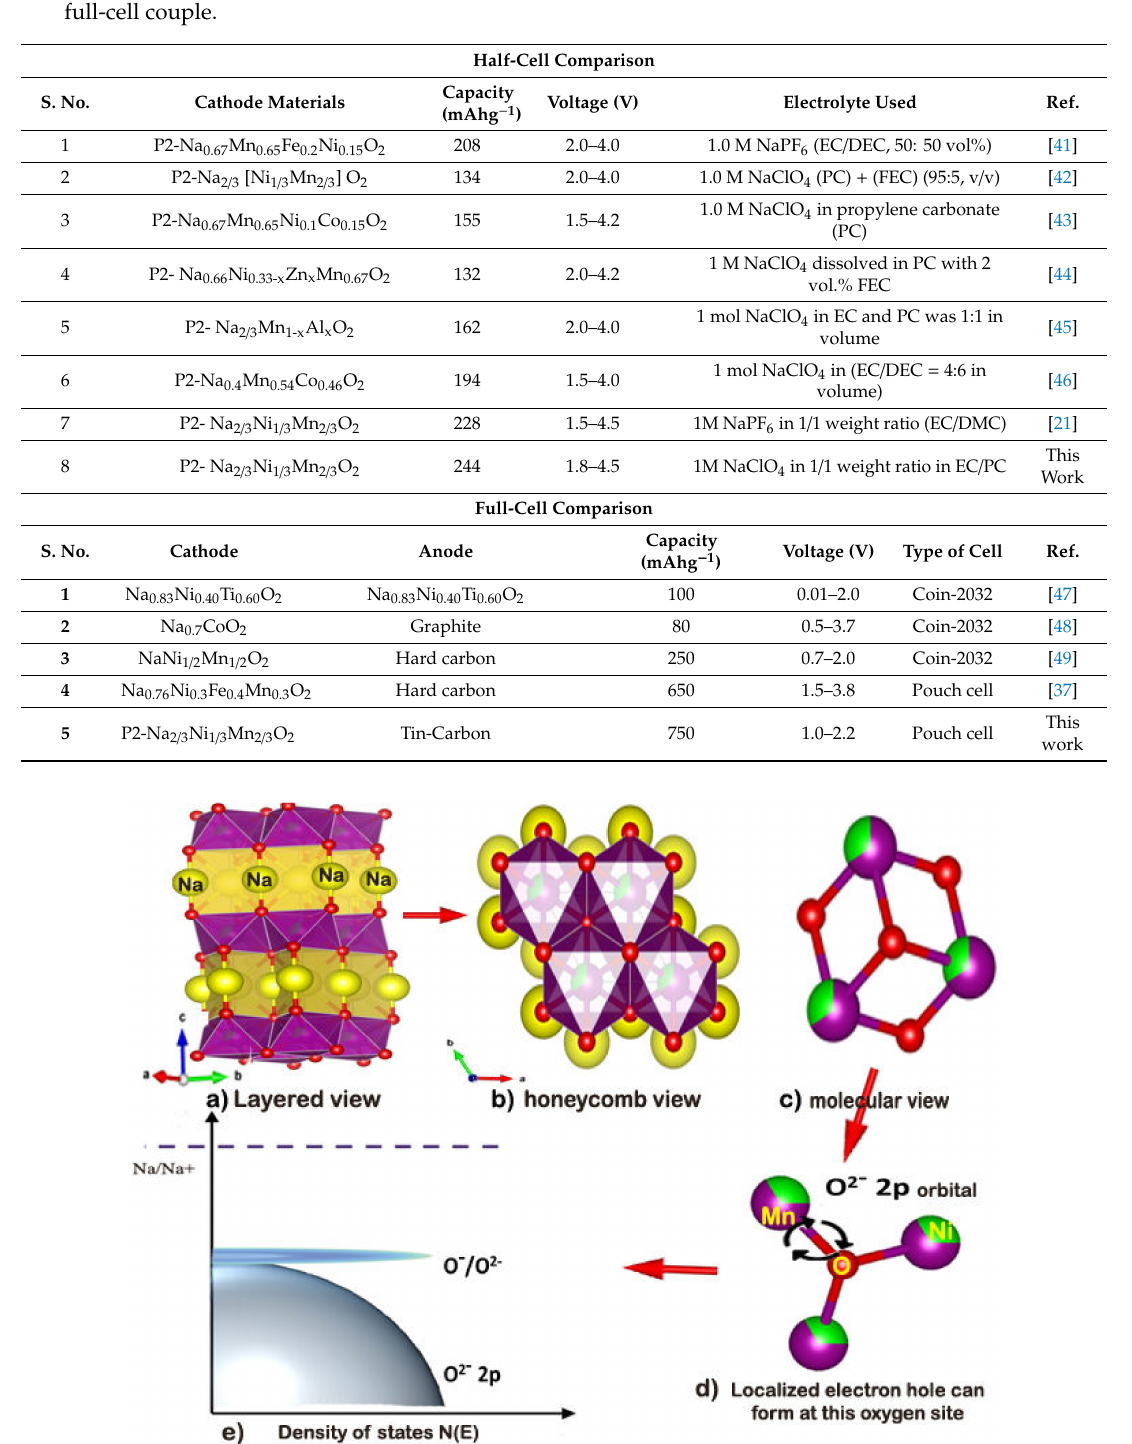
Figure 5. Schematic of the charge compensation mechanism by anionic redox. ( a ) Layered structure of P2-Na 2 / 3 Ni 1 / 3 Mn 2 / 3 O 2 where the sodium ion bonded between metal oxide slabs. ( b ) Honeycomb view of the cation ordering in the metal oxide layer in P2-Na 2 / 3 Ni 1 / 3 Mn 2 / 3 O 2 viewed along the c-axis. ( c , d ) molecular view of oxygen coordination by Mn 4 + and Ni 2 + and these promote a localized electron hole on oxygen due to a relative ionic Mn 4 + / –O interaction. ( e ) Schematic of energy versus the density of states, which can show the position of O − / O 2 −